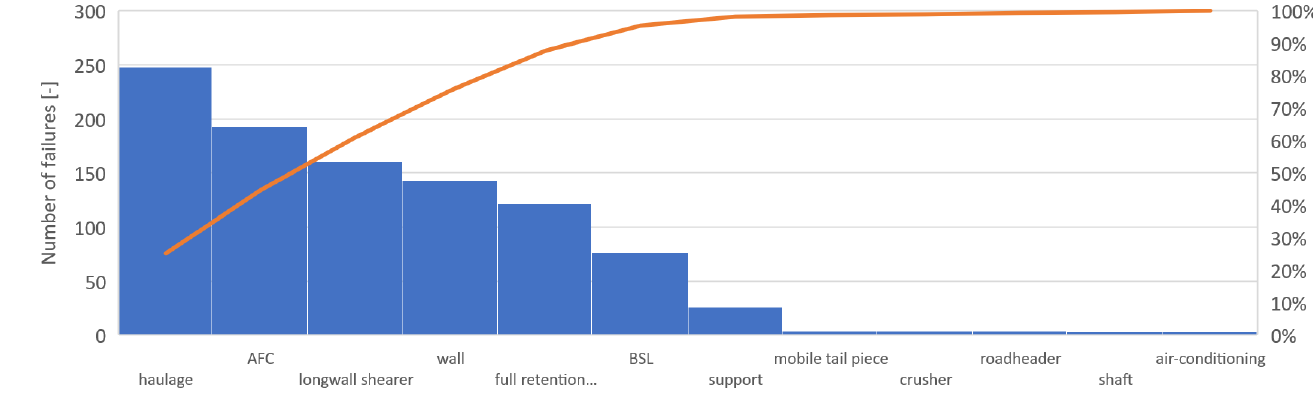
Figure 6. Pareto chart for the total number of shearer longwall failures.